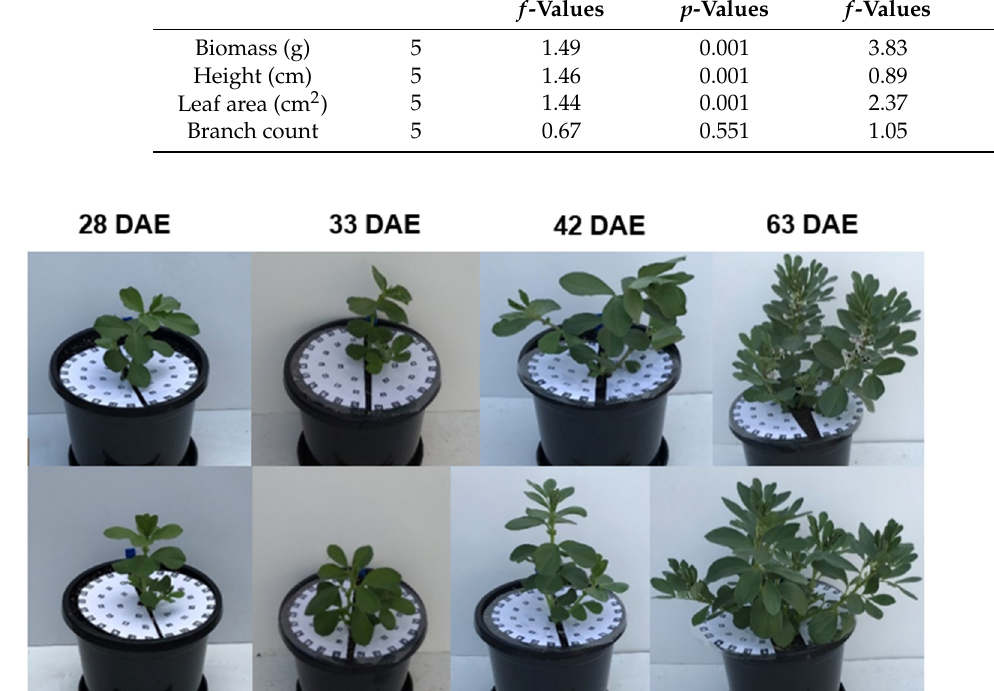
Figure 2. Growth comparison of cultivars PBA Nanu (top) and PBA Zahra (bottom) at four different sampling times at Toowoomba, QLD site. (DAE = Days after emergence). Table 3. Dry biomass (g) of different faba bean cultivars grown in Narrabri and Toowoomba. Means with a different letter are significantly different at P -value ( α = 0.05).